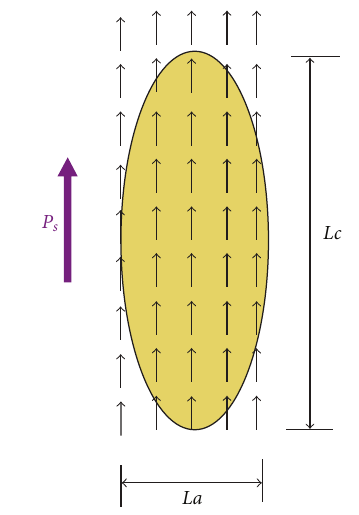
Figure 9: Ferroelectric correlation region in dipolar materials